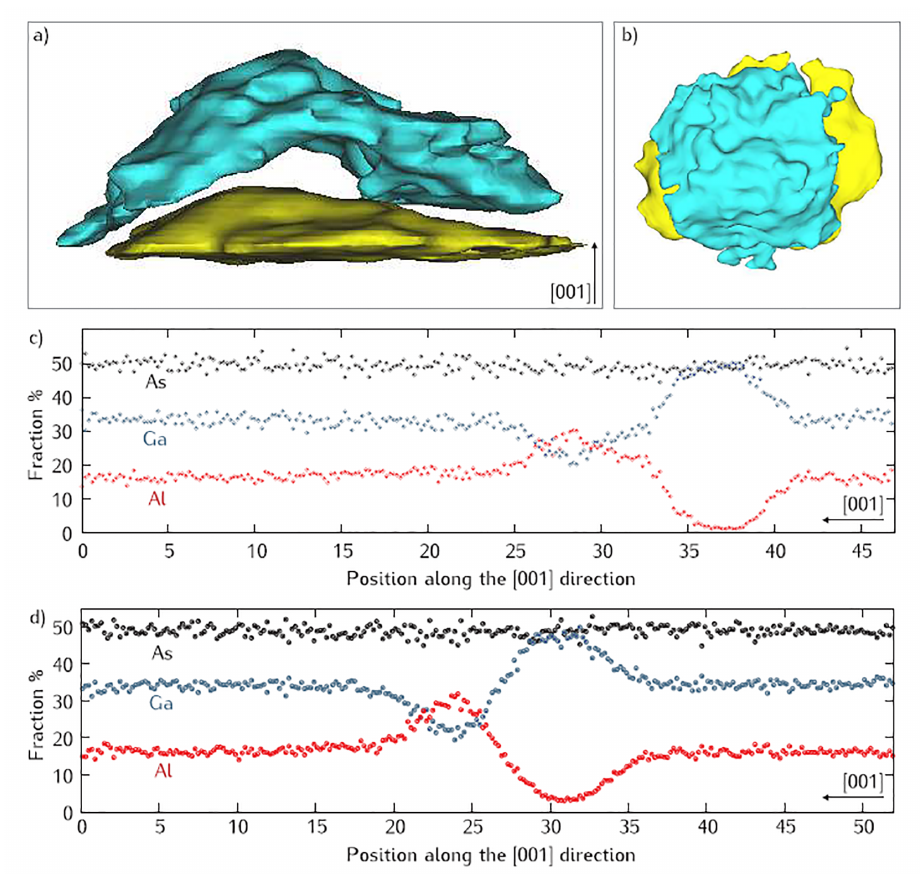
Figure 12. 88% Ga iso-surface (yellow) and 50% Al iso-surface (blue) in a 3D APT data set, outlining a QD grown from 3 MLs of Ga, and its Al-rich cap: ( a ) 40 × 20 nm 2 side view; ( b ) 50 × 50 nm 2 top view; Ga and Al concentration profiles along the [001] direction for a QD grown from ( c ) 3 ML of Ga and ( d ) 5 ML of Ga. The Al-rich cap is separated from the pure GaAs by an intermixed region. Adopted from Ref.